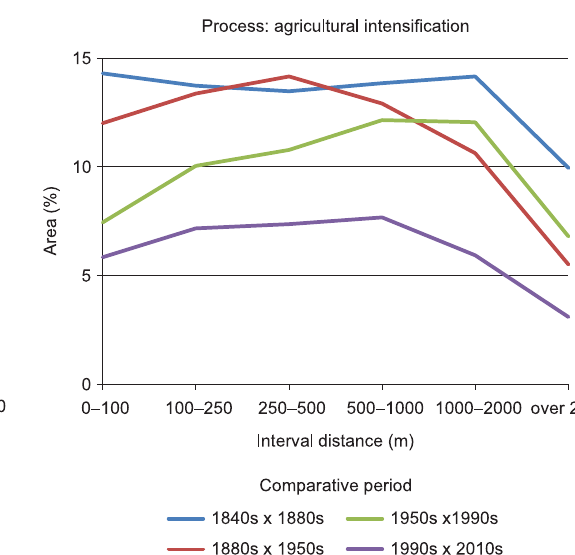
Fig. 9. Agricultural intensification (in%) in the Hodonín region at various distances from existing roads.